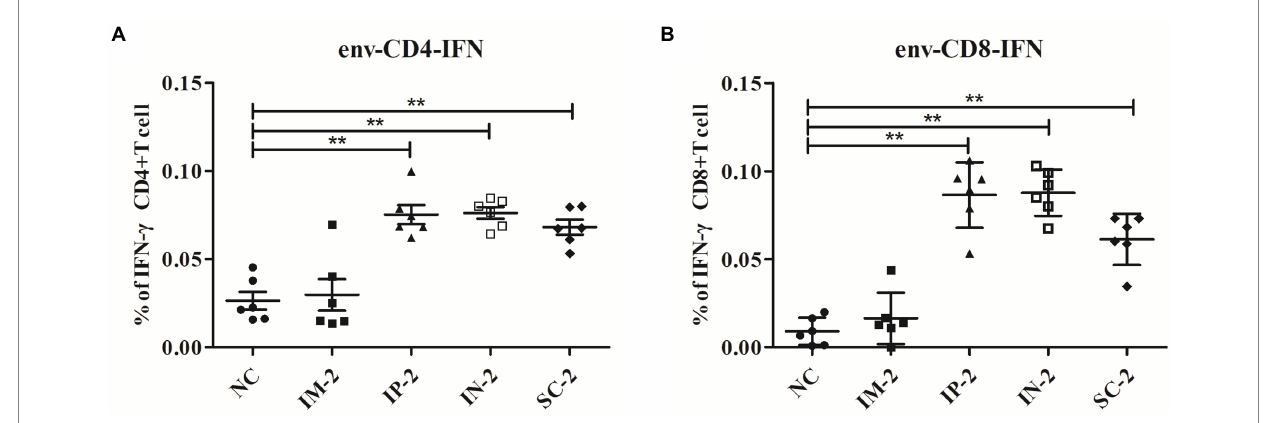
FIGURE 3 HIV-1 envelope-specific CD4 and CD8 T cell responses elicited with different administration routes. 56 days after the first injection, mice from different vaccination groups (IM, IP, IN, SC and NC group) were humanly euthanized and spleens collected. T cell responses against HIV-1 envelop-specific peptides were analyzed by flow cytometry. The percentages of activated CD4 + (A) and CD8 + (B) T cells that produce IFN- γ were detected by intracellular cytokine staining. ** p < 0 0.001.